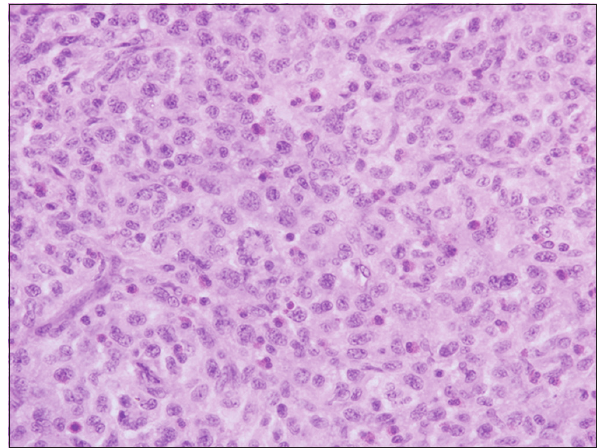
Figure 1: Cellular lesion comprised polymorphous cell population of histiocytes, lymphocytes, scattered prominent eosinophils, and few multinucleated giant cells. (H and E,